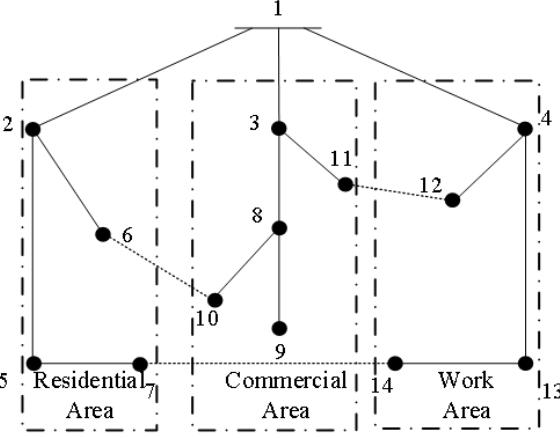
Figure 4. Diagram of the IEEE 14-node distribution network system.